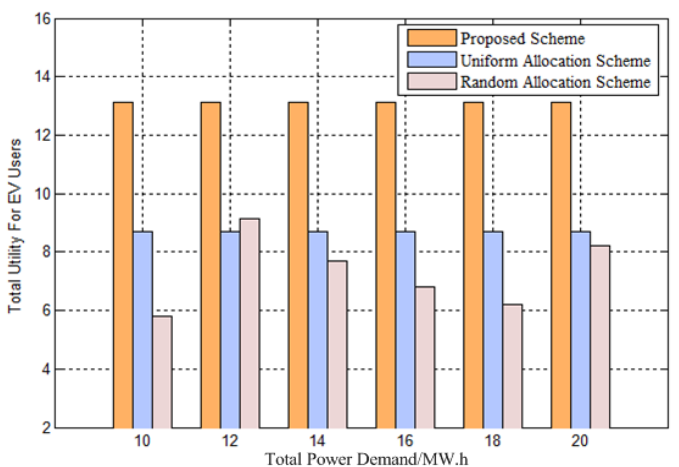
Figure 8. Total utility for EV users with different schemes, in which ζ 1 = 0.05 and ζ 2 = 0.01, and